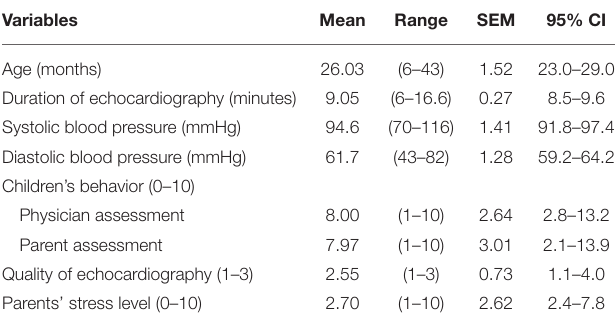
TABLE 1 | Distribution of the study variables.